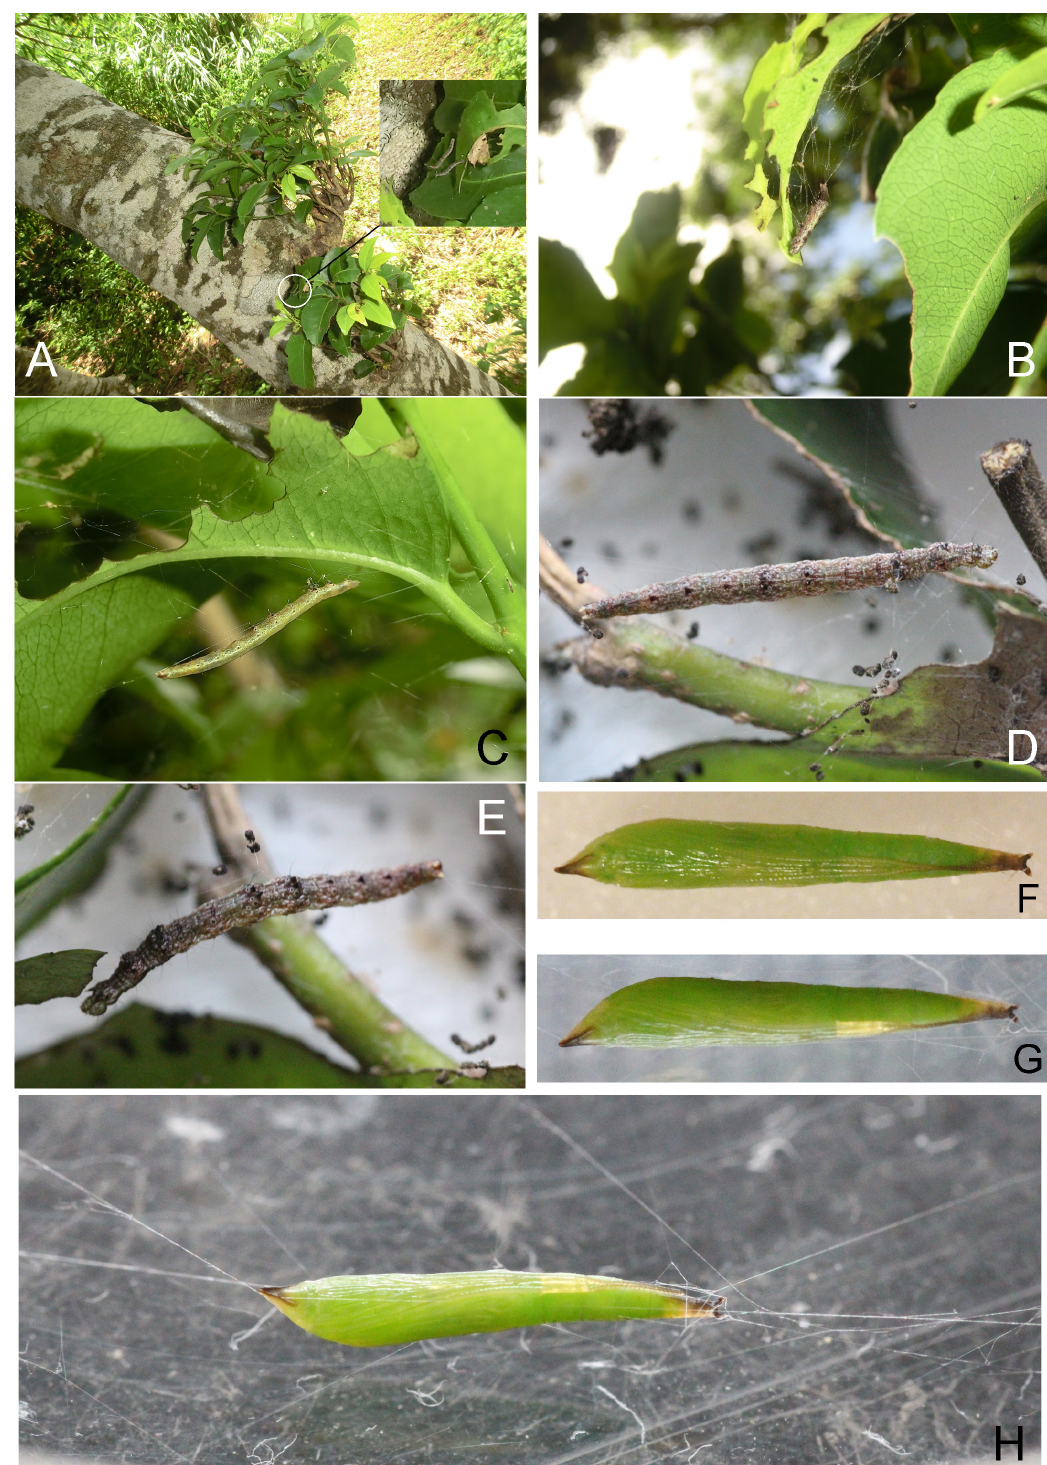
Fig. 3. Larvae and pupae of Tonza citrorrhoa Meyrick, 1905 on Putranjiva matsumurae Koidz. A . Tree of hostplant and larval webs. B . Later larva forming web on young leaves. C . Later larva, lateral view. D . Mature larva, dorsal view. E . Same, ventral view. F . Pupa, ventral view. G . Same, lateral view. H . Pupa at the joint of some cross silken threads, lateral